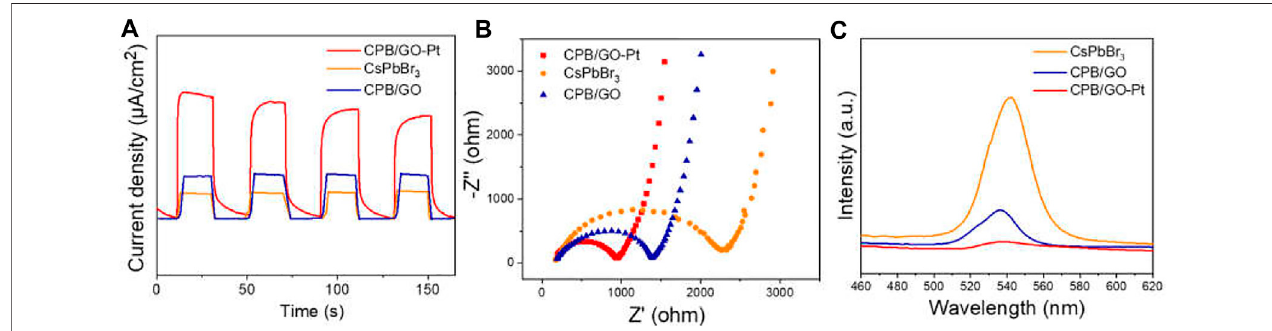
FIGURE 2 | (A) Chopped photocurrent responses, (B) Nyquist plots, (C) PL spectra of CsPbBr 3 , CPB/GO, and CPB/GO-Pt